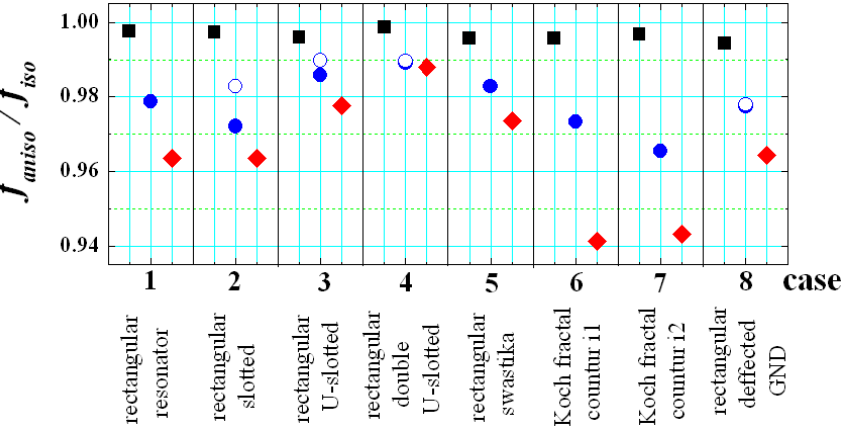
Figure 17. Simulated values of the ratio f aniso / f iso between the resonance frequencies of the lowest- order mode in several planar resonance structures with dimensions 30 × 30 mm on anisotropic and isotropic substrates ( h s = 0.52; ∆ A ε ~ 25%) (this ratio gives the pure effect of anisotropy). The shapes of the considered structures are presented in Figures 18 and 19. The first column for each case corresponds to a flat structure, second—bent at α C = 8 ◦ ; third—bent at α C = 12 ◦ ; Solid and hollow points correspond to two mutually perpendicular orientations (V & H) of the structure during the bending (when this is possible).